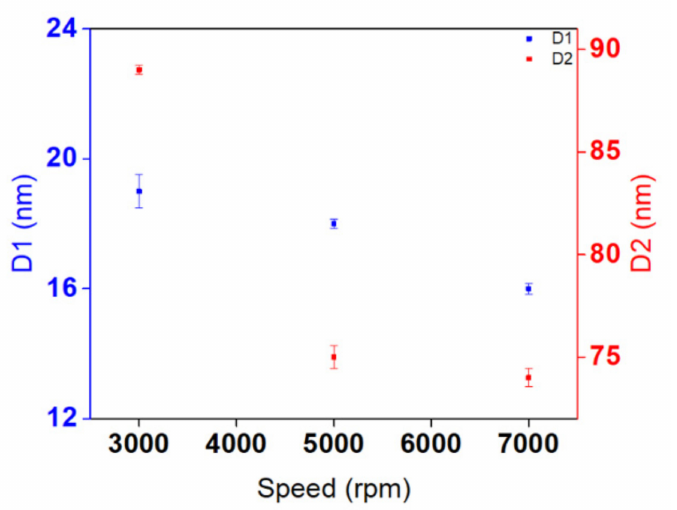
Figure 3. Average diameters (D1 and D2) of AgNPs with their correlated error bars versus spin- coating